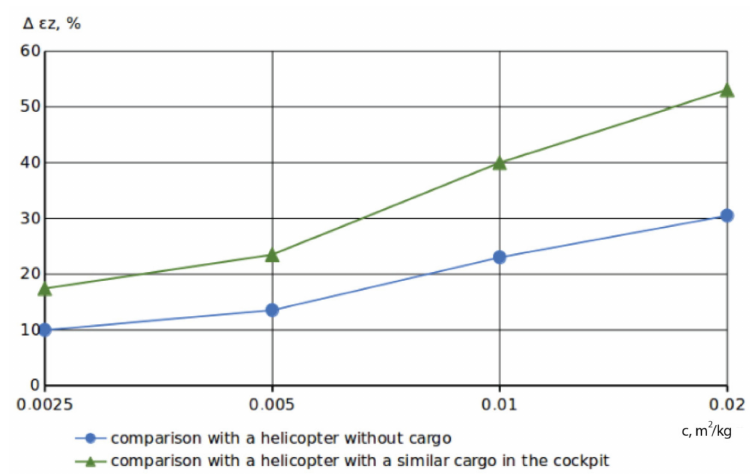
Figure 4. Influence of ballistic coefficient of cargo on pitch angular acceleration.